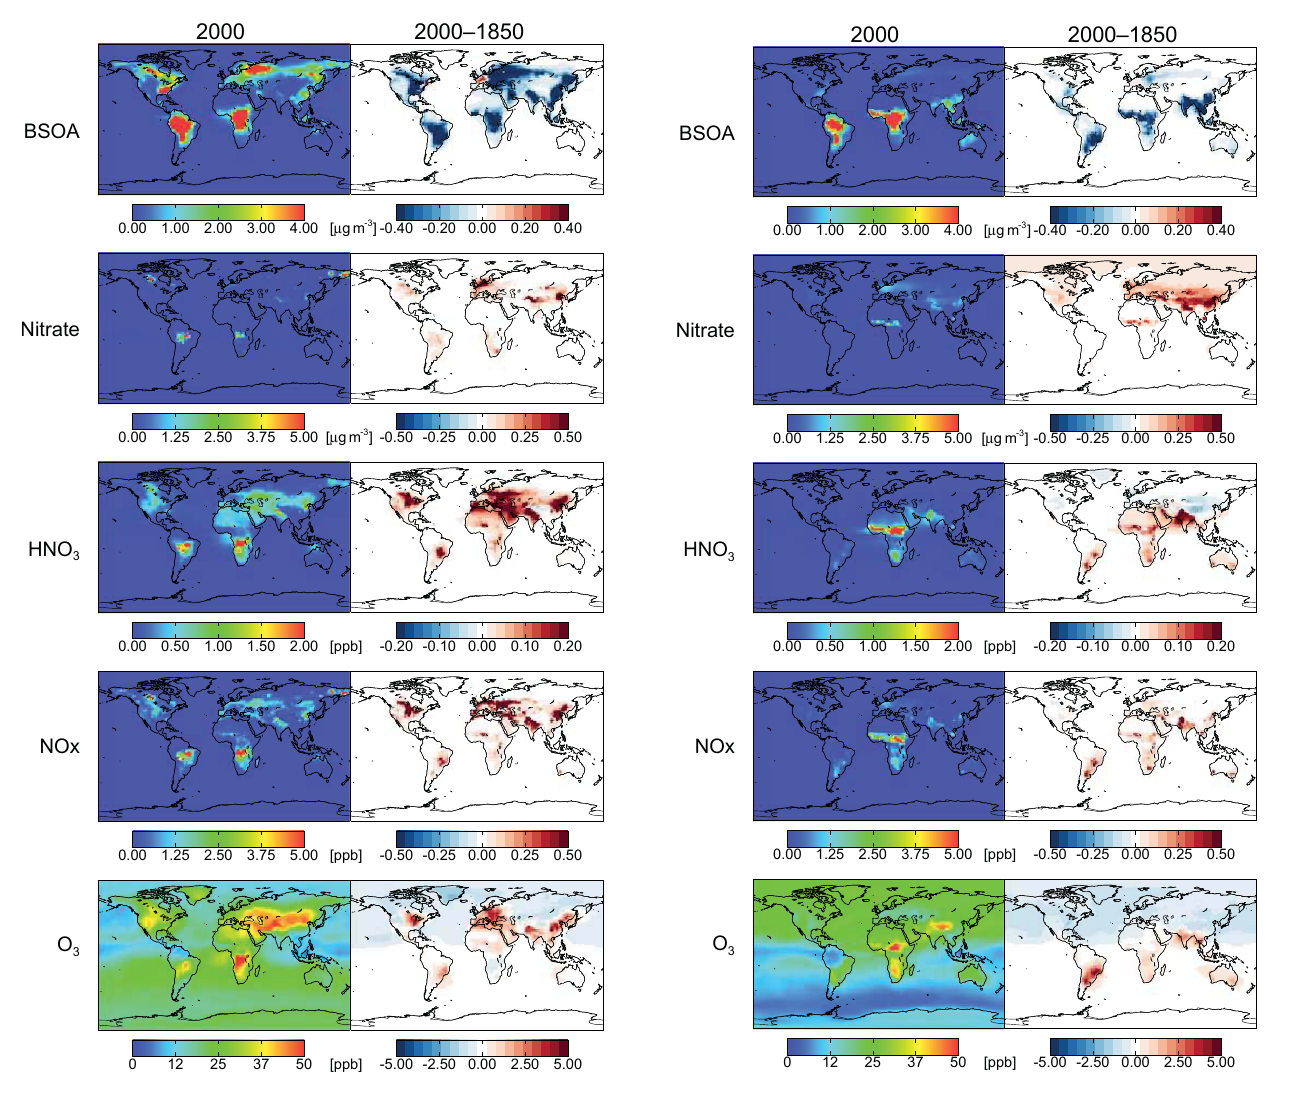
Figure 9. Boreal summertime (June–August) mean simulated sur- face concentrations of biogenic SOA (BSOA), aerosol nitrate, nitric acid (HNO 3 ) , nitrogen oxides (NO x ), and ozone. Concentrations for present day (2000) shown on the left; the change due to histori- cal land use change is shown on the right. All simulations performed with preindustrial (1850) anthropogenic emissions; shown here are the differences between simulations 6 and 4 (see Tables 1 and 2). Shown with same colour bars as Fig. 7 for comparison.